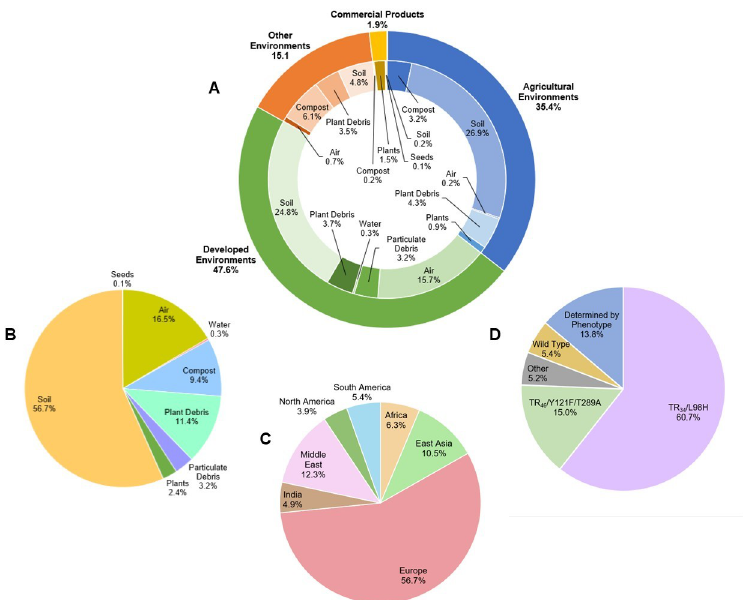
Fig 2. Frequency of azole-resistant Aspergillus fumigatus isolates detected in the environment by (A) environmental setting and substrate sampled, (B) substrate sampled across all environmental settings, (C) geographic region, and (D) cyp51A allele (“Other” includes less frequently detected cyp51A alleles and “Determined by Phenotype” includes resistant isolates that were not analyzed for cyp51A polymorphisms (S1